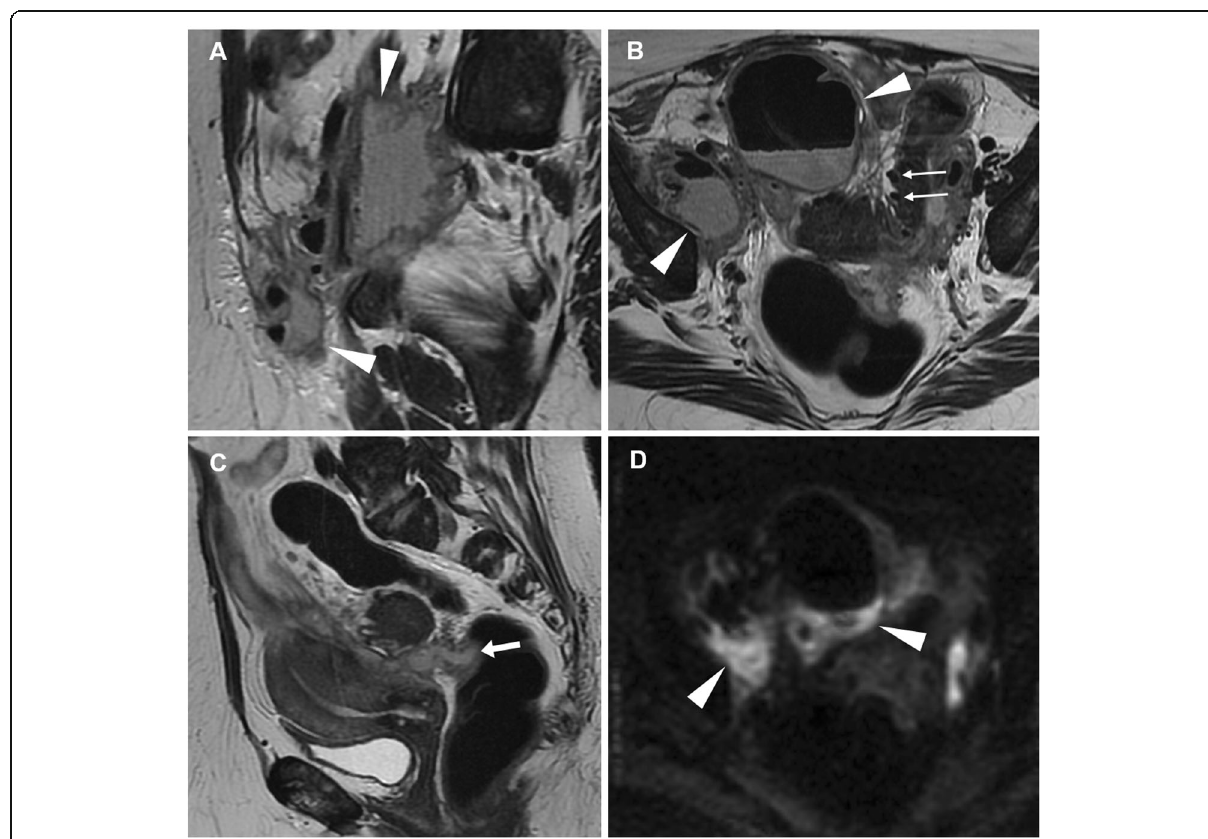
Fig. 20 TOA in a 57-year-old woman with right lower quadrant pain, fever, leukocytosis and acute diverticulitis. Sagittal ( a ) and axial ( b ) T2- weighted images show heterogeneous, multilocular collections at the right adnexa (arrowheads), containing air-fluid levels. Note diverticula of the sigmoid colon (thin arrows in b ). Sagittal T2-weighted image ( c ) displays a fluid collection in the Douglas pouch (arrow). On axial DWI ( b = 800 s/mm 2 ) image ( d ), the fluid component of the adnexal masses demonstrates high signal intensity (arrowheads), consistent with restricted diffusion from purulent content